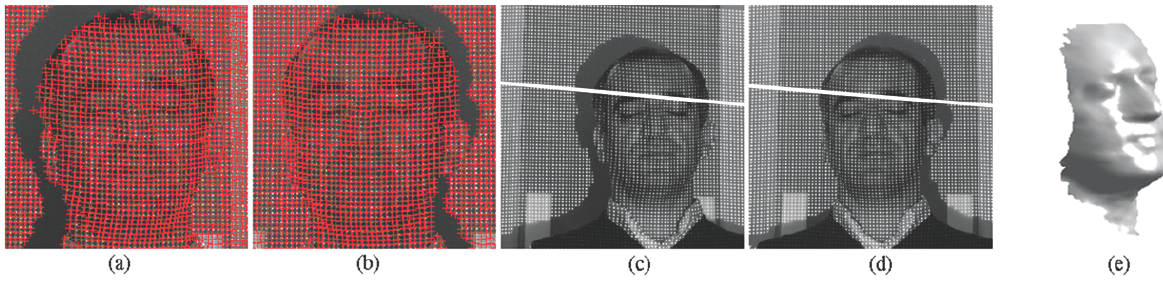
2. Training of RBF : The proposed method uses a 3-layered RBF neural network in order to map